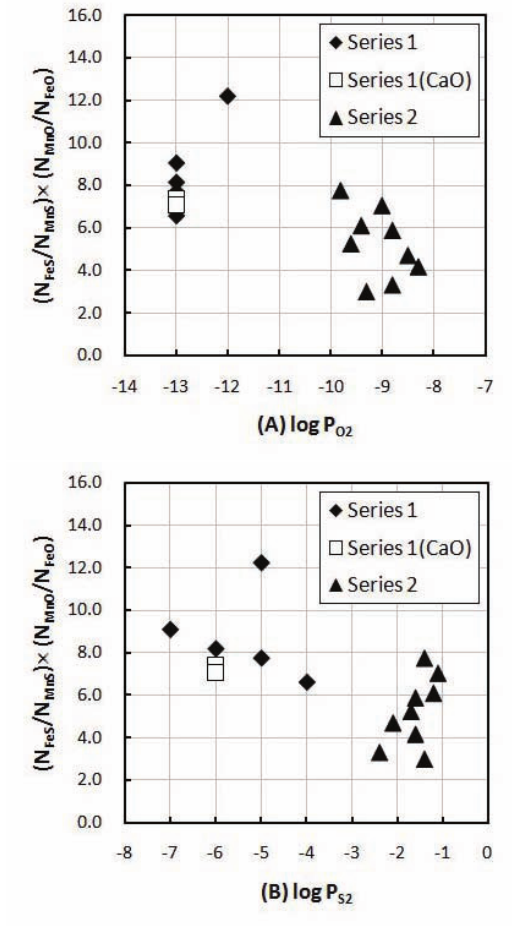
(A) and P S (B) with the 2 2